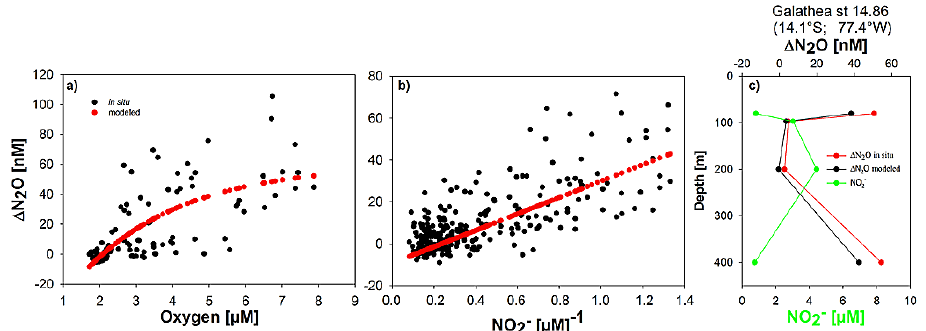
Fig. 3. (a) 1 N 2 O in situ (black circles) and modeled according to Bonin experiments (red circles) varying with the oxygen; (b) 1 N 2 O in situ (black circles) and modeled (red circles) as a function of inverse NO − concentrations; (c) profile of 1 N 2 O in situ (red points) and modeled 2 as a function of NO − (black points) and NO − concentrations (green points) from Galathea expedition station 2 2